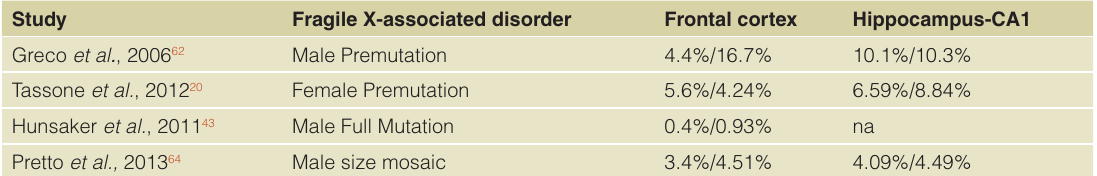
Table 1. Tabulation of intranuclear inclusion bodies in neurons and astroglia respectively in Fragile X Premutation carrier males and females as well as Full Mutation carrier males and a male that was mosaic for the length of the CGG repeat expansion carrying both Premutation and Full Mutation alleles. Data from Greco et al. , 2006 62 ; Hunsaker et al ., 2011 43 ; Pretto et al ., 2013 64 ; and Tassone et al. , 2012 20